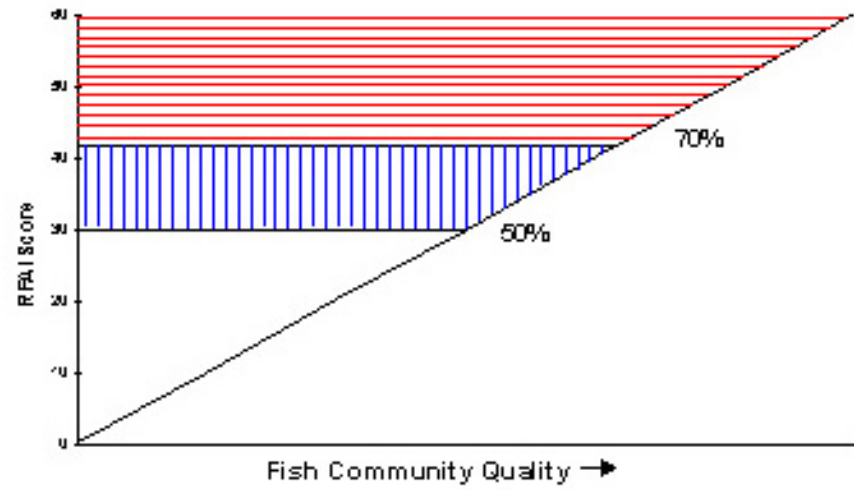
FIGURE 2. Proposed RFAI endpoints for determination of adverse environmental impact. If RFAI score is > 70% of attainable score, then the fish community is considered to “screen out” for AEI and have BIP; between 50–70% is considered potentially adversely impacted; and < 50% is considered